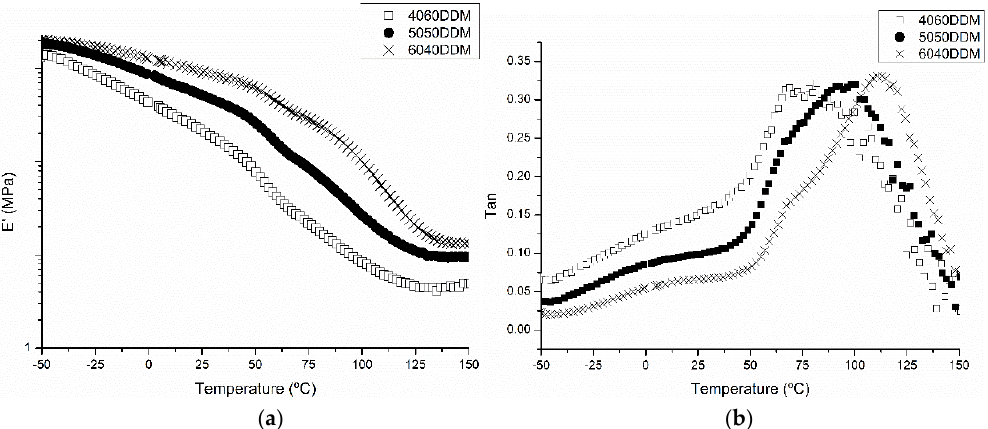
Figure 6. Modulus ( a ) and Tan δ ( b ) vs. temperature for different DGEBA/PCL composition samples cured with DDM.